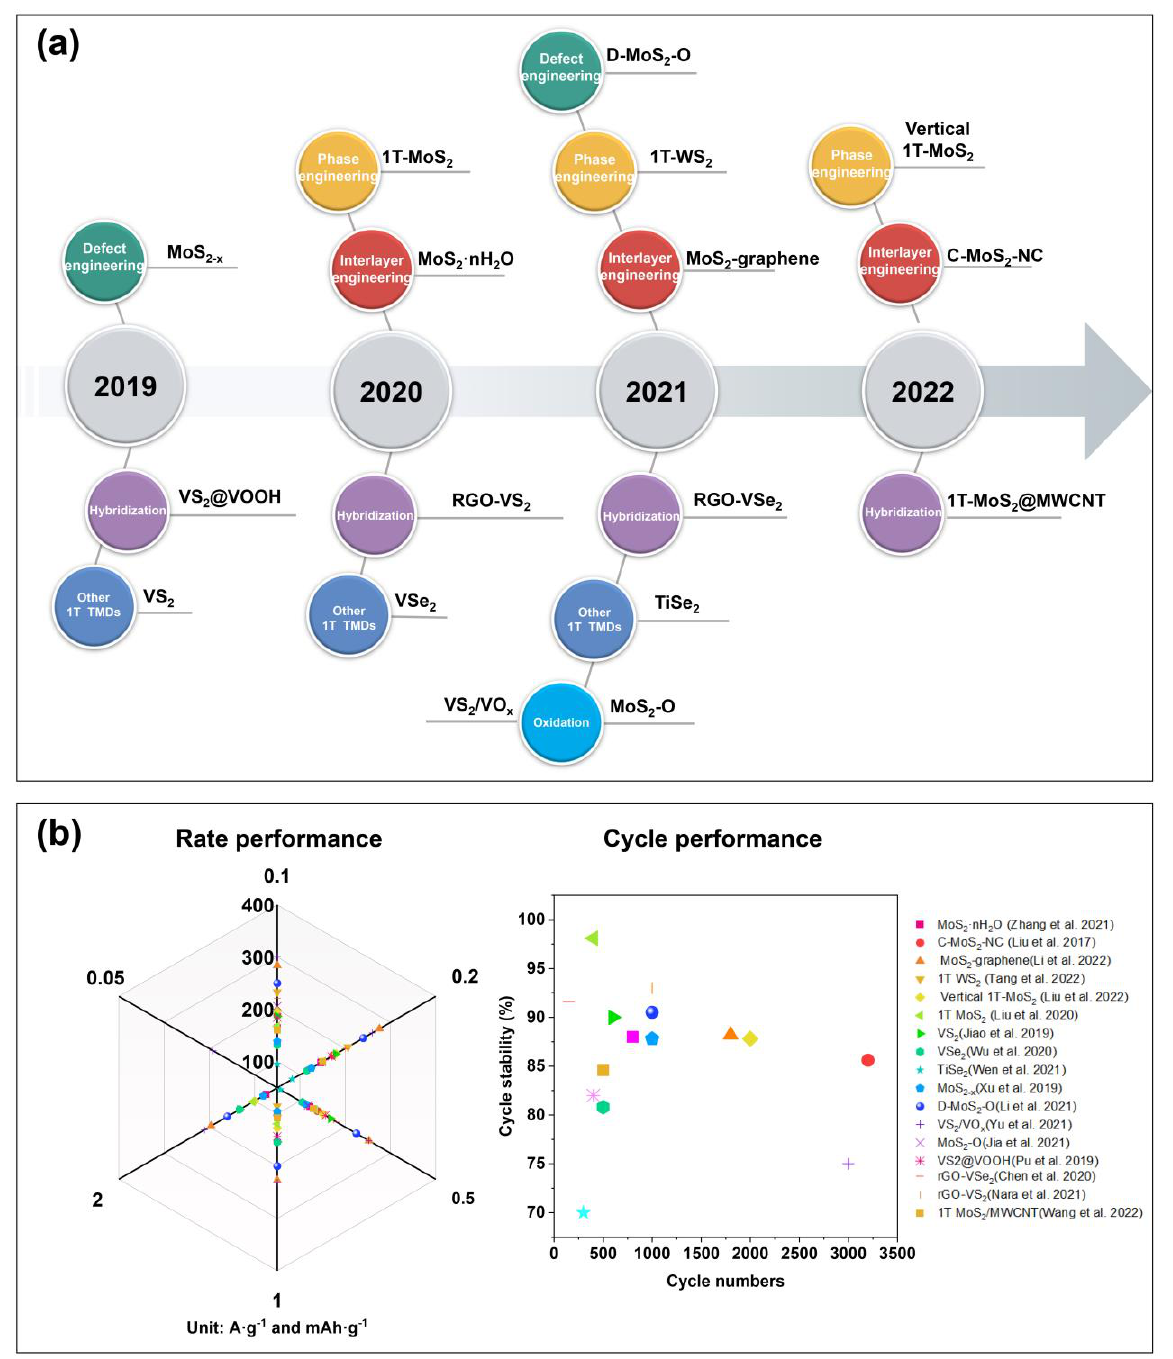
Figure 8. Summary of modified TMDs for high − performance ZIBs. ( a ) Timeline of developed strategies for TMD − based ZIB cathode. ( b ) The radar chart of the electrochemical performance of TMD materials as ZIB cathode. Refs. [12,14,16 – 18,22,23,28,29,42 – 44,47,51,54,55].